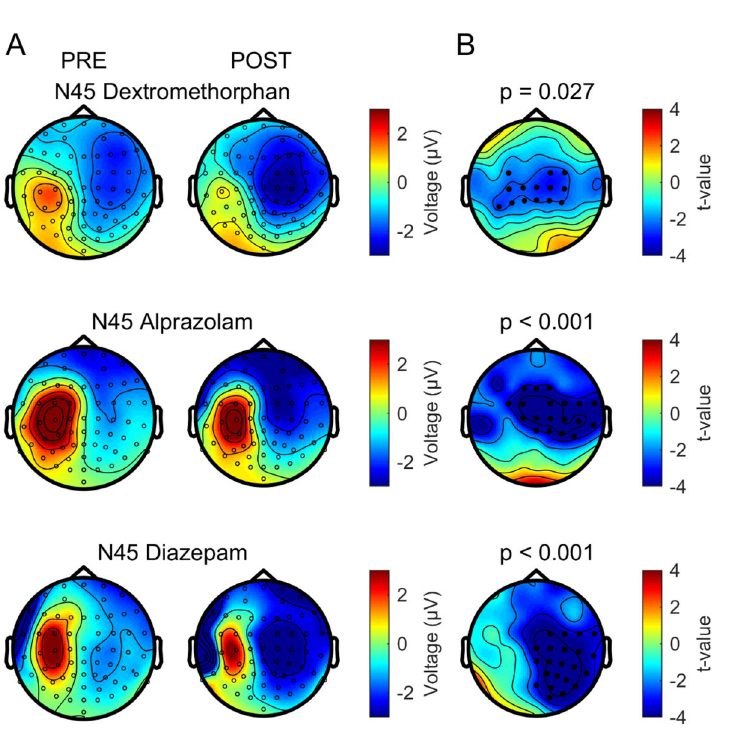
Figure 8. Comparison of the modulation of the N45 TEP by dextromethorphan and two classical benzodiazepines (alprazolam and diazepam, results adapted from Ref. 12 , with the consent of the authors). ( A ) Voltage surface maps of the N45 TEP recorded pre- and post-drug intake. ( B ) T-statistic maps of the N45 cluster post- vs. pre-drug differences. Electrodes of the significant clusters are denoted by black dots. Figure generated with MATLAB R2016a (https:// www. mathw orks. com) and the Fieldtrip Matlab toolbox (http:// www. field tript oolbox.